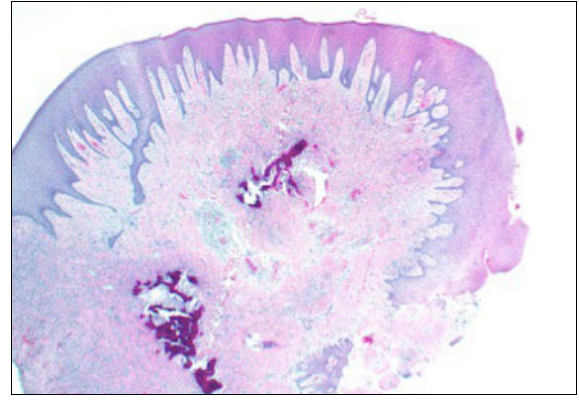
Figure 2a. Nodule surfaced by parakeratinized epithelium (hematoxylin and eosin, magnification × 20).